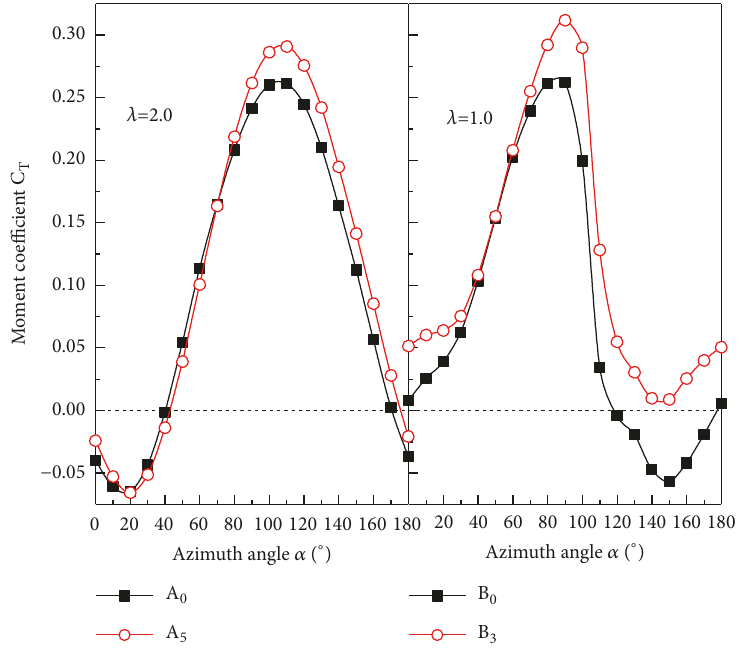
Figure 7: Torque coefficients in one rotation